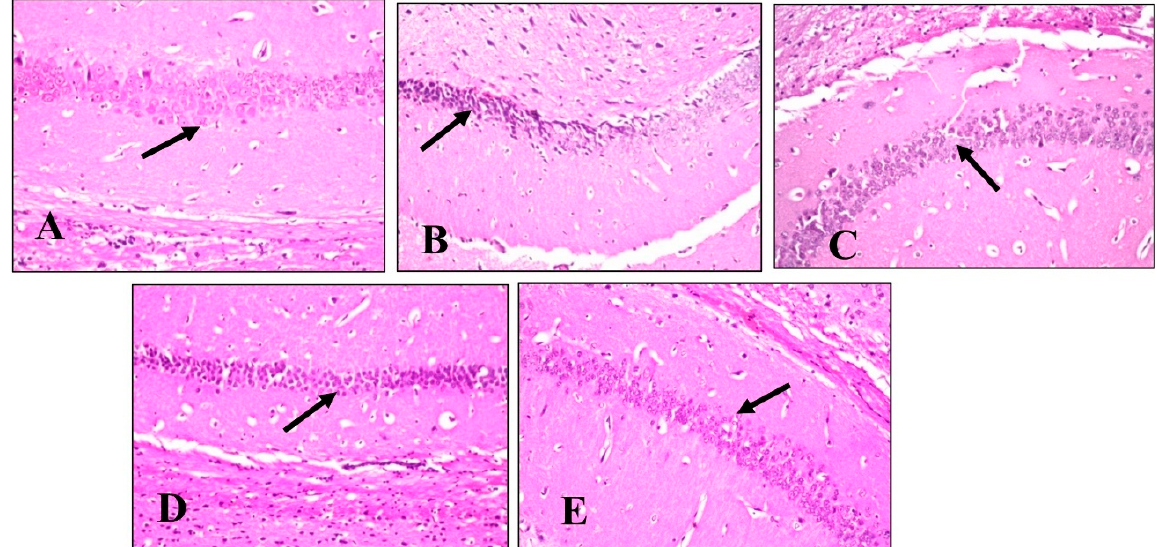
Figure 7. Histopathology of mice brain (Subiculum in hippocampus sections) with H&E × 40. ( A ) Normal control group showing normal histological findings (Black arrow-normal neuron). ( B ) LPS-administered mice group showing nuclear pyknosis and degeneration of some neurons (Black arrow) ( C ) BME-administered mice group showing normal histological findings (Black arrow-normal neuron). ( D ) BDMF-administered mice group showing normal histological findings (Black arrow-normal neuron). ( E ) BBF-administered mice group showing normal histological findings (Black arrow-normal neuron). BME: B. armeniaca methanolic extract; BDMF: B. armeniaca dichloromethane fraction; BBF: B. armeniaca butanol fraction; LPS: lipopolysaccharide.